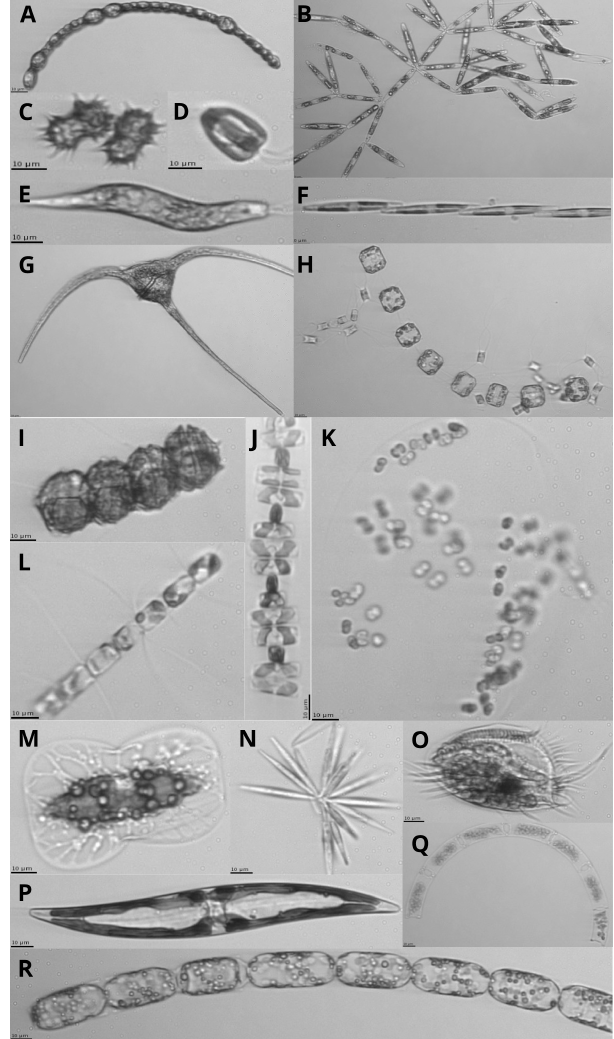
Figure 12. Images of protists sampled with the IFCB (scale bar on images is 10µm; note that the images are not to scale): (a) An- abaena sp., (b) Nitzschia frigida , (c) Polarella glacialis , (d) Flagel- late, (e) Euglena, (f) Pseudo-nitzschia sp., (g) Ceratium sp., (h) Tha- lassiosira nordenskioeldii with Attheya septentrionalis , (i) Peri- diniella catenata , (j) Navicula pelagica , (k) Phaeocystis sp. colony, (l) Chaetoceros sp., (m) Entomoneis sp., (n) Synedropsis hyper- borea , (o) Ciliate, (p) Pennate diatom, (q) Eucampia sp., and (r) Melosira